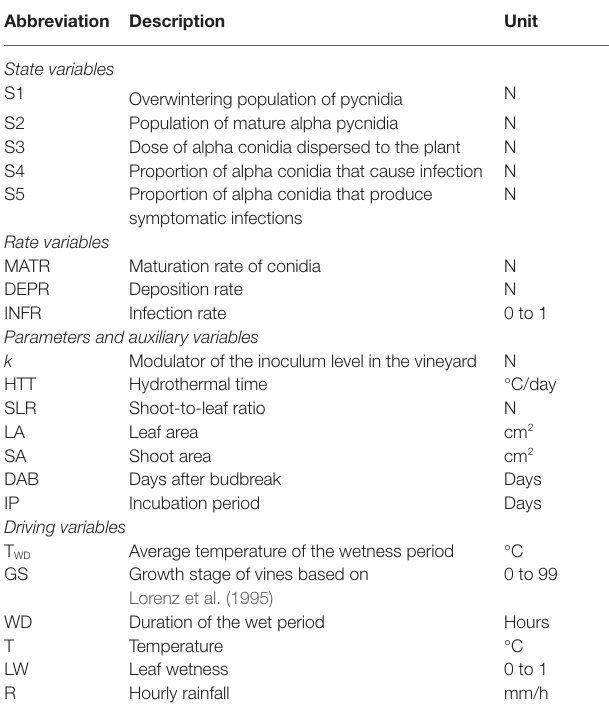
TABLE 1 | List of variables, rates, and parameters used in the